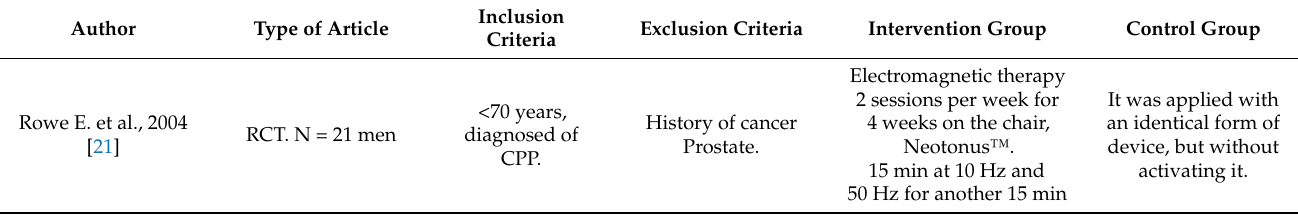
Table 4. Revised studies on magnetic therapy in patients with